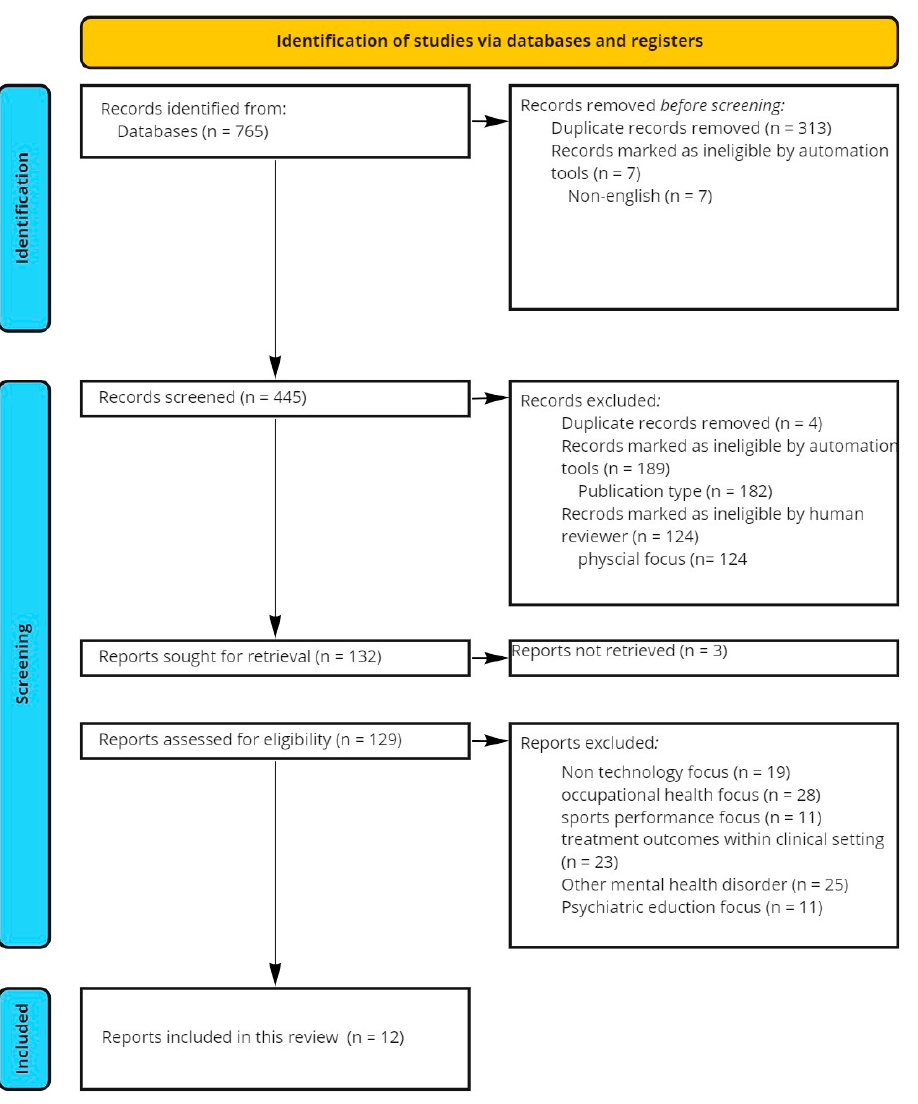
Figure 1. PRISMA flowchart detailing identification, screening, and inclusion of records for this